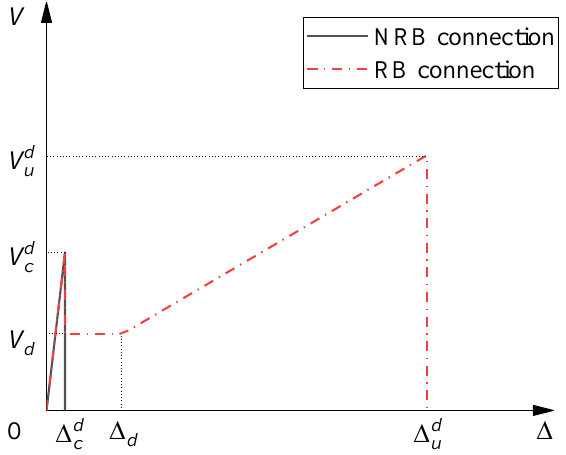
Figure 14. Typical V - ∆ plots for NRB and RB connection.